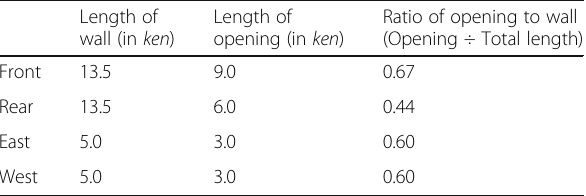
Table 1 Ratio of opening to walls of the sericulture space in the omoya when originally built. (Source: Sweet Yee Cheng) Length of Length of wall (in ken ) opening (in ken